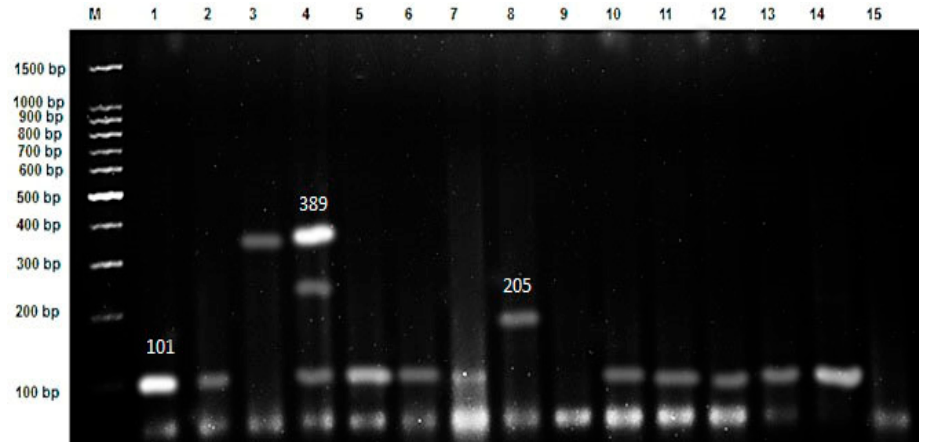
Figure 3. Ethidium bromide-stained 1.5% agarose gel with multiplex PCR products showed C. botulinum neurotoxin genes from 15 bacterial isolates from the Alexandria governorate (lanes 1–15), where M represents a 1500 bp DNA ladder.